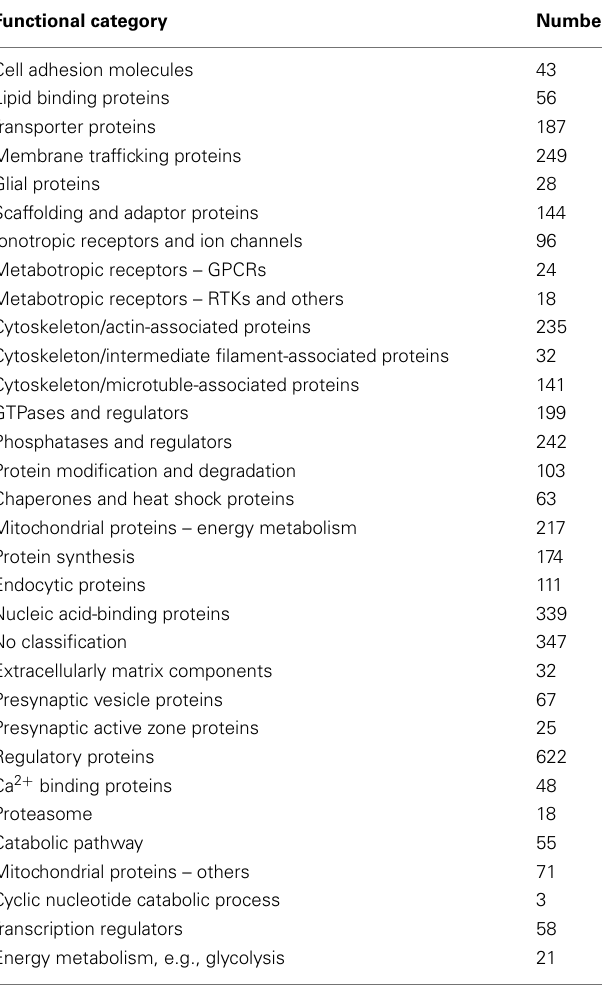
Table 3 | Statistical analysis of the 32 manual assigned functional